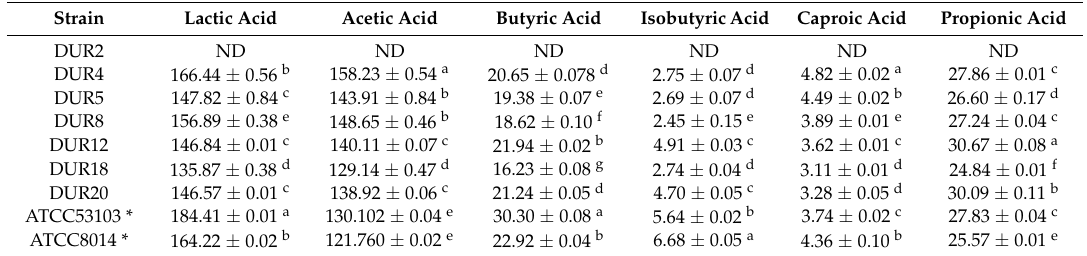
Table 8. Organic acid production (mM) profile of the Lactobacillus strains 1